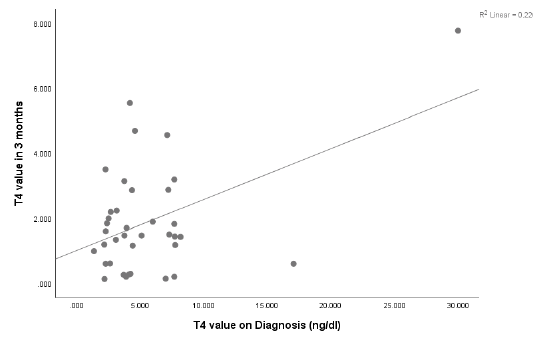
Figure 2: The Scatter plot showing the relationship between the FT4 value on diagnosis and the FT4 value before giving the Radioiodine therapy.